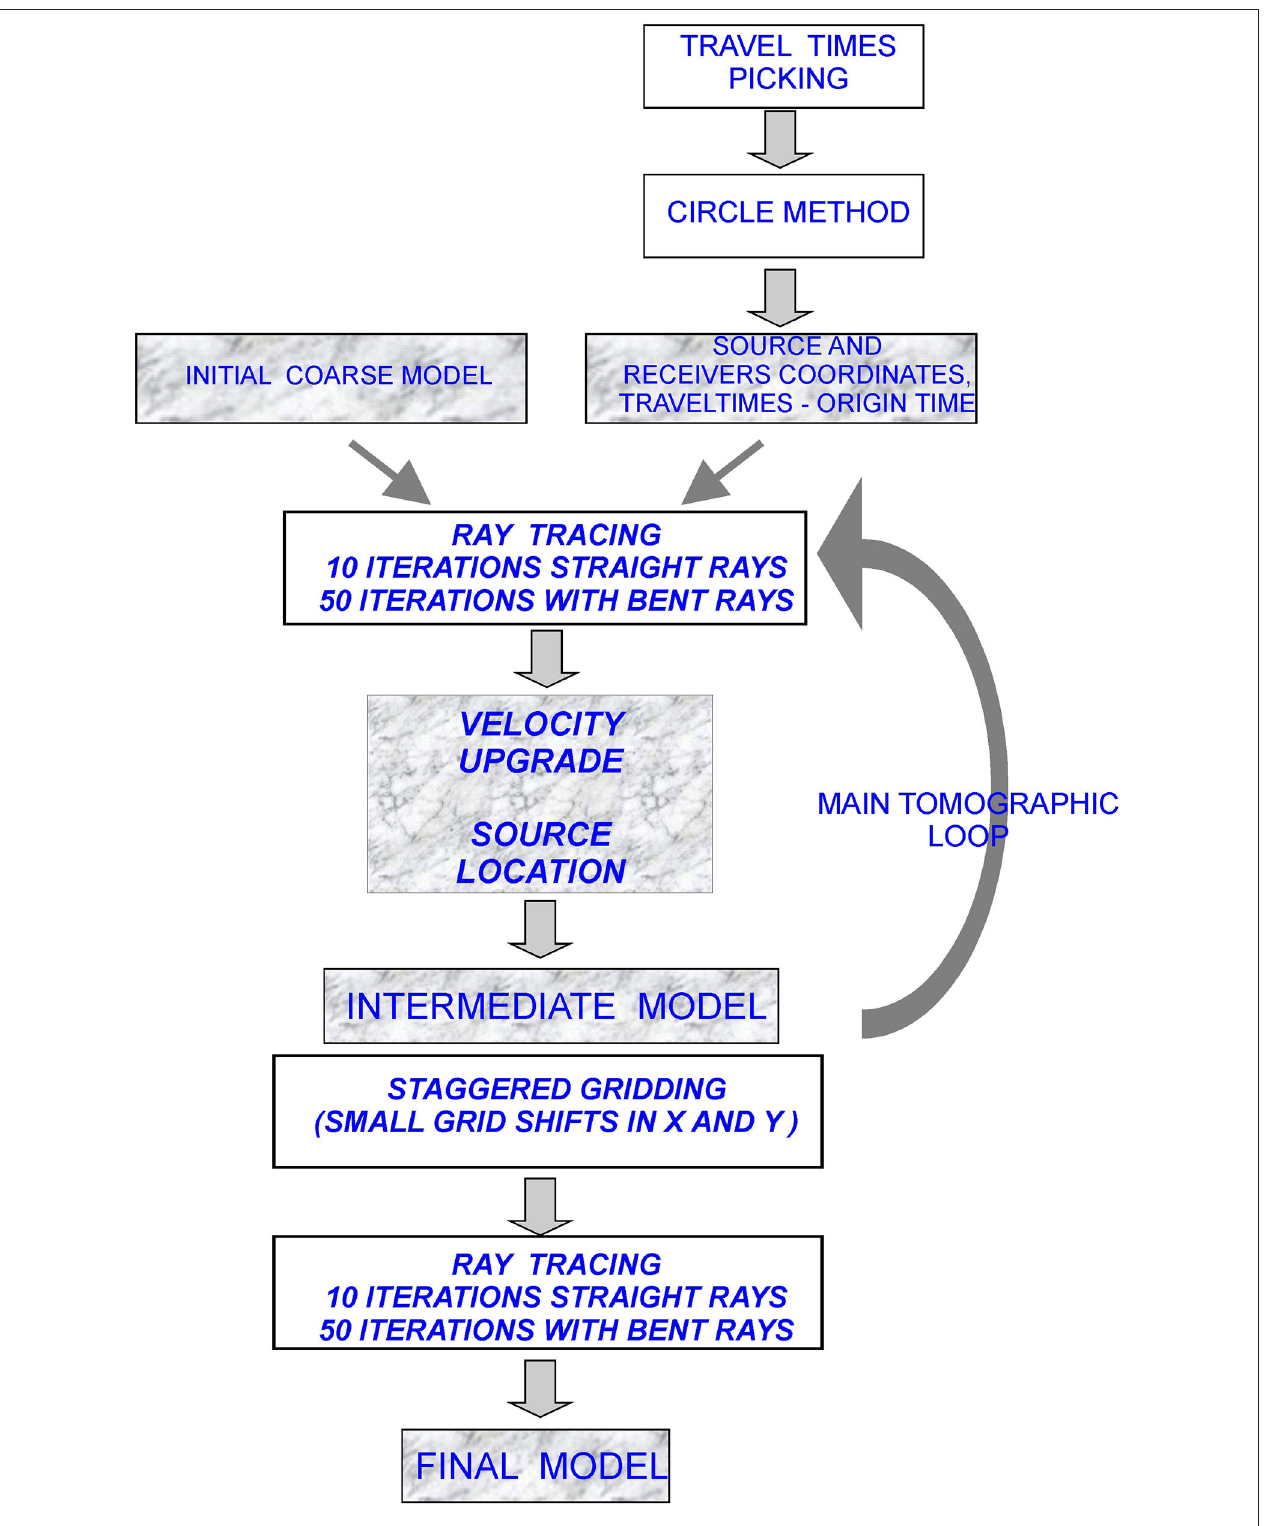
FIGURE 9 | Scheme of the data analysis: retrieval of the source location and origin time (circle method), velocity model refinement (ray tracing method).